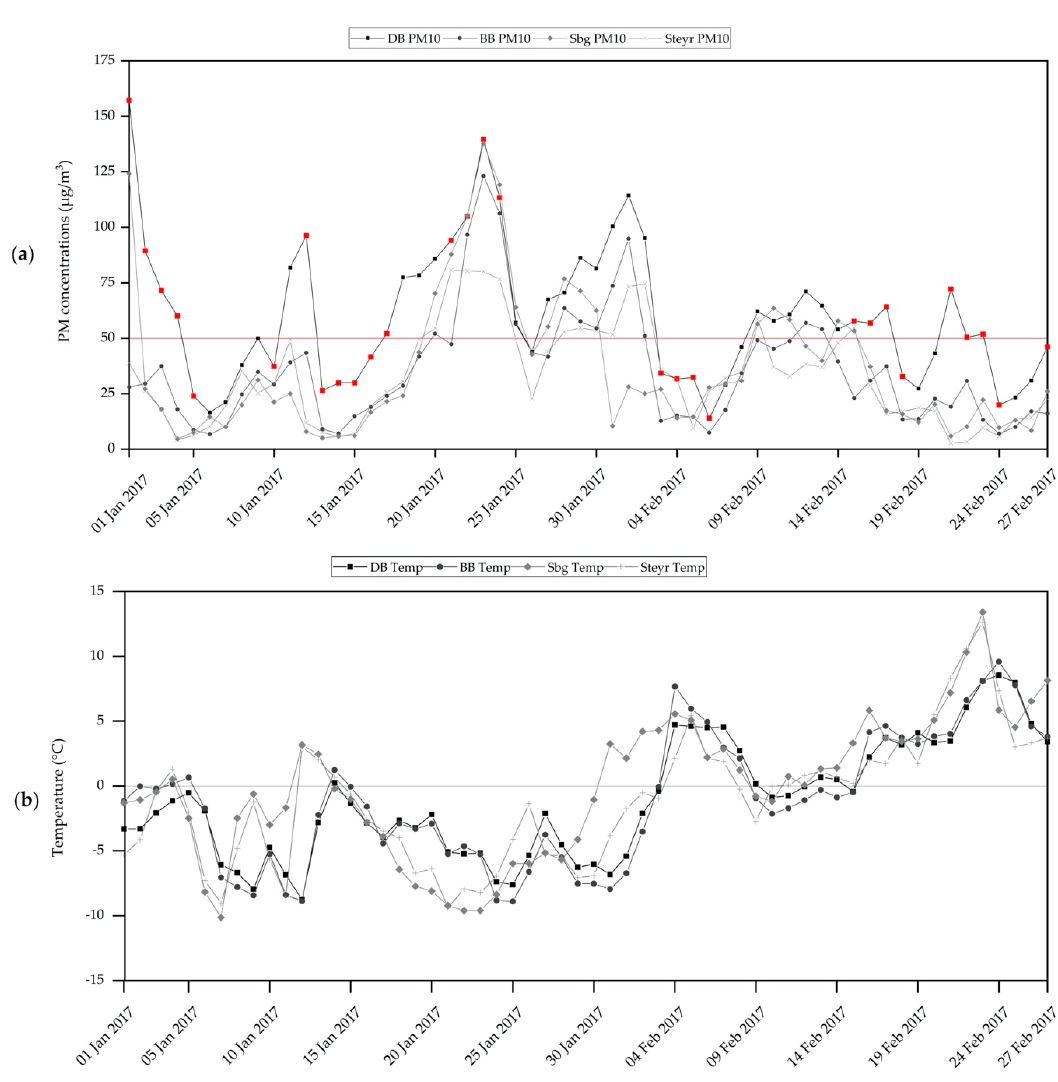
Figure 11. ( a ) Time series of PM concentrations of different sampling sites in Austria including study sites DB and BB. Red highlighted data points mark days influenced by local inversion (red highlighted symbols) in Graz. ( b ) Time series of ambient air temperature (°C) of different monitoring sites in Austria collocated or in vicinity of the air quality monitoring sites given in (a). Abbreviations: Sbg = Salzburg.